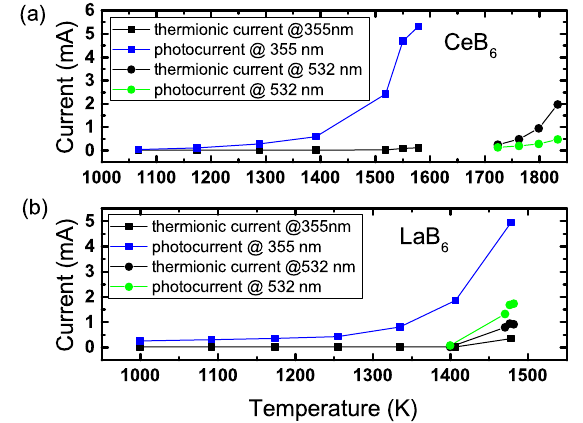
FIG. 9. Thermionic and photocurrent for different cathode temperatures: (a) CeB 6 for excitation by laser of 355 nm at 12 μ J and of 532 nm at ∼ 84 μ J; (b) LaB 6 for excitation by laser of 355 nm at ∼ 13 μ J and of 532 nm at ∼ 32 μ J.